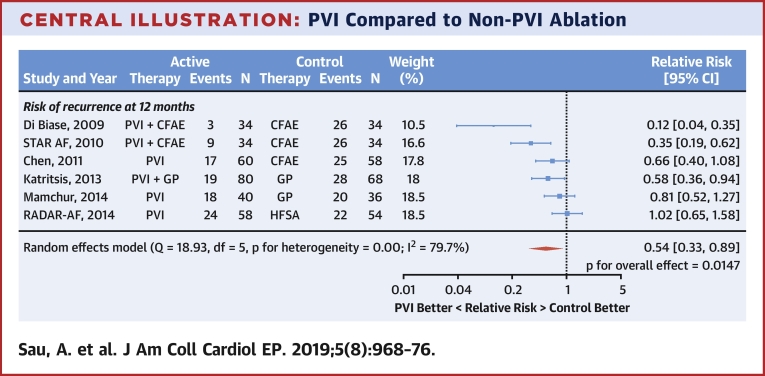
PVI Compared to Non-PVI AblationPVI increases freedom from atrial arrhythmia by 46% compared to non-PVI ablation. CFAE = complex fractionated atrial electrogram; GP = ganglionated plexi; HFSA = high-frequency source ablation; PVI = pulmonary vein isolation; RADAR-AF = Radiofrequency Ablation of Drivers of Atrial Fibrillation; STAR-AF = Substrate Versus Trigger Ablation for Reduction of Atrial Fibrillation Trial.